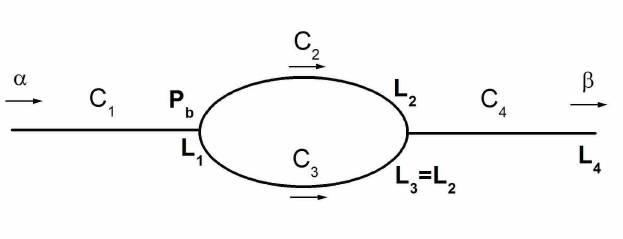
Fig. 3. Schematic representation of the network: a single chain with a two-chain incertion. The segments C 2 and C 3 have equal length L 2 ( L 3 = L 2 ) in the case under consideration. The particles are injected at the left end with a rate α and removed at the right end with a rate β . The particles move from left to right, at the branching point P b = L 1 they take with equal probability the upper or the lower